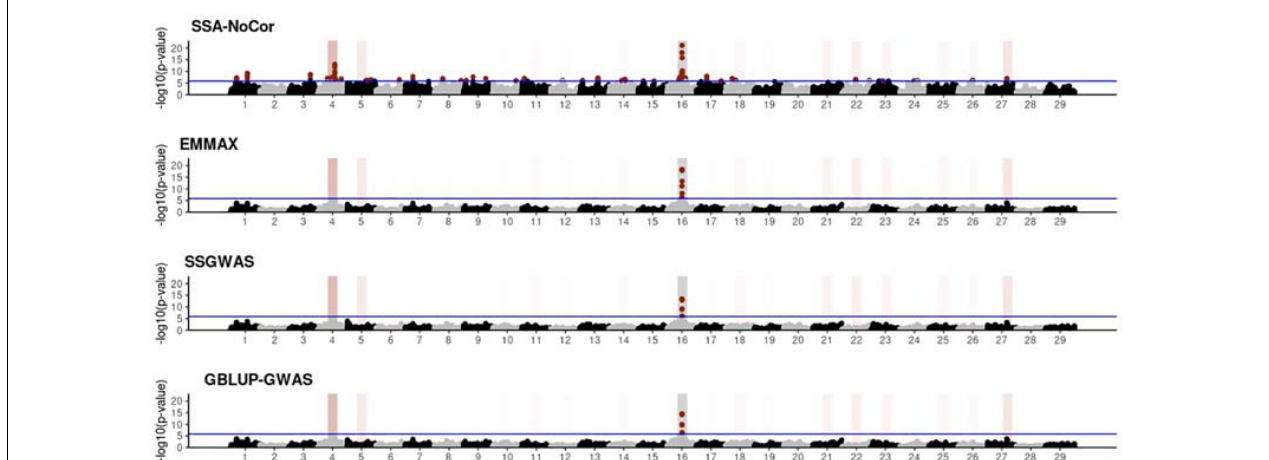
FIGURE 5 | Manhattan plots for the small population of fish using single-SNP analysis without correction for population structure (SSA-NoCor), efficient mixed-model association expedited (EMMAX), single-step GWAS (ssGWAS), and genomic best linear unbiased prediction GWAS (GBLUP-GWAS). Significant SNPs are indicated in red, whereas vertical bars indicate the position of the simulated quantitative trait nucleotide (QTN). The darker the vertical bar, the stronger QTN effect. The blue horizontal line corresponds to the rejection threshold based on a significance level of 0.05 with a Bonferroni correction for multiple testing.